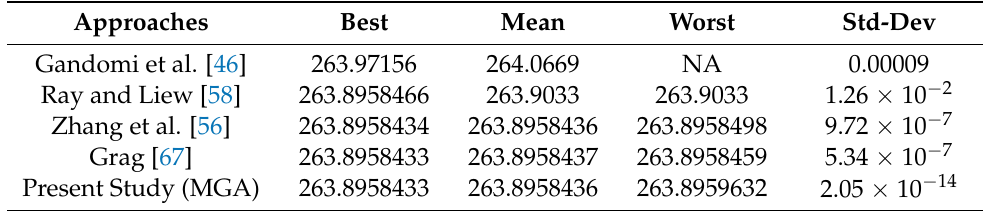
Table 12. Statistical results of different approaches for the three-bar truss design problem.